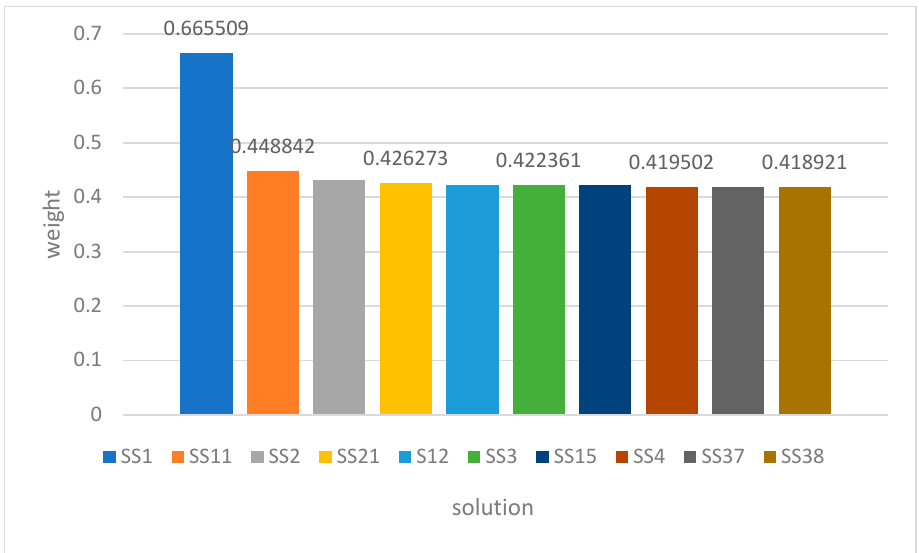
Figure 15. Prioritizing the suitable designs of the summing and subtracting amplifier.